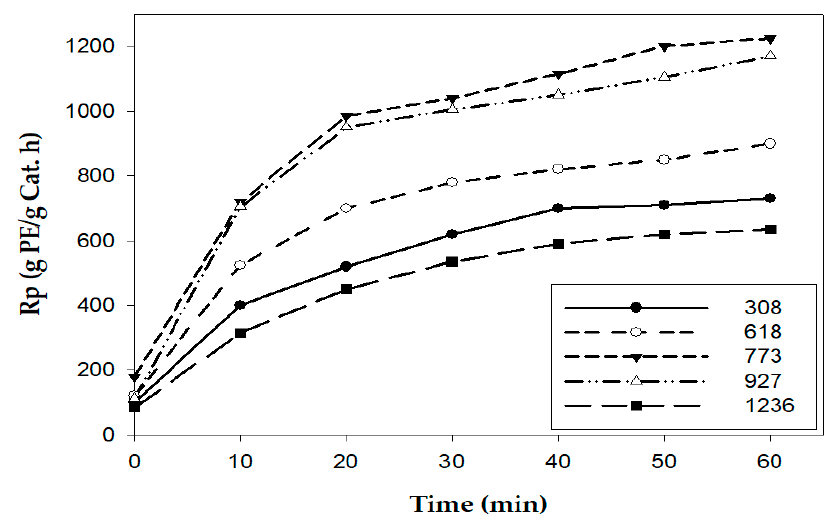
Figure 2. Corresponding rate profiles of the ethylene homopolymerization carried out using various [Al]/[Ti] molar ratios.